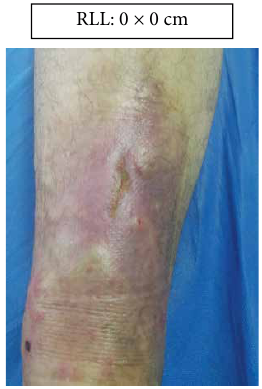
Figure 19: Week 10. Lower right limb.